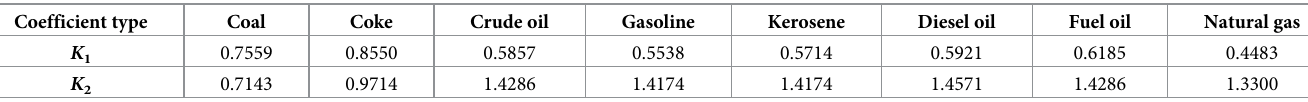
Table 3. The correlation